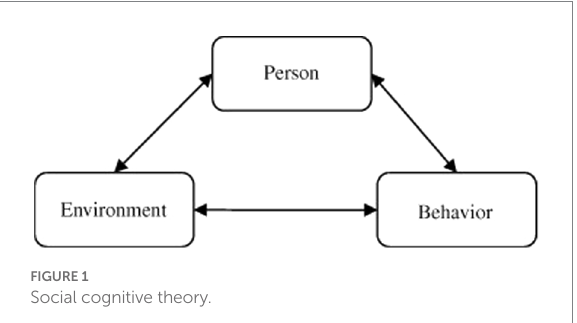
FIGURE 1 Social cognitive